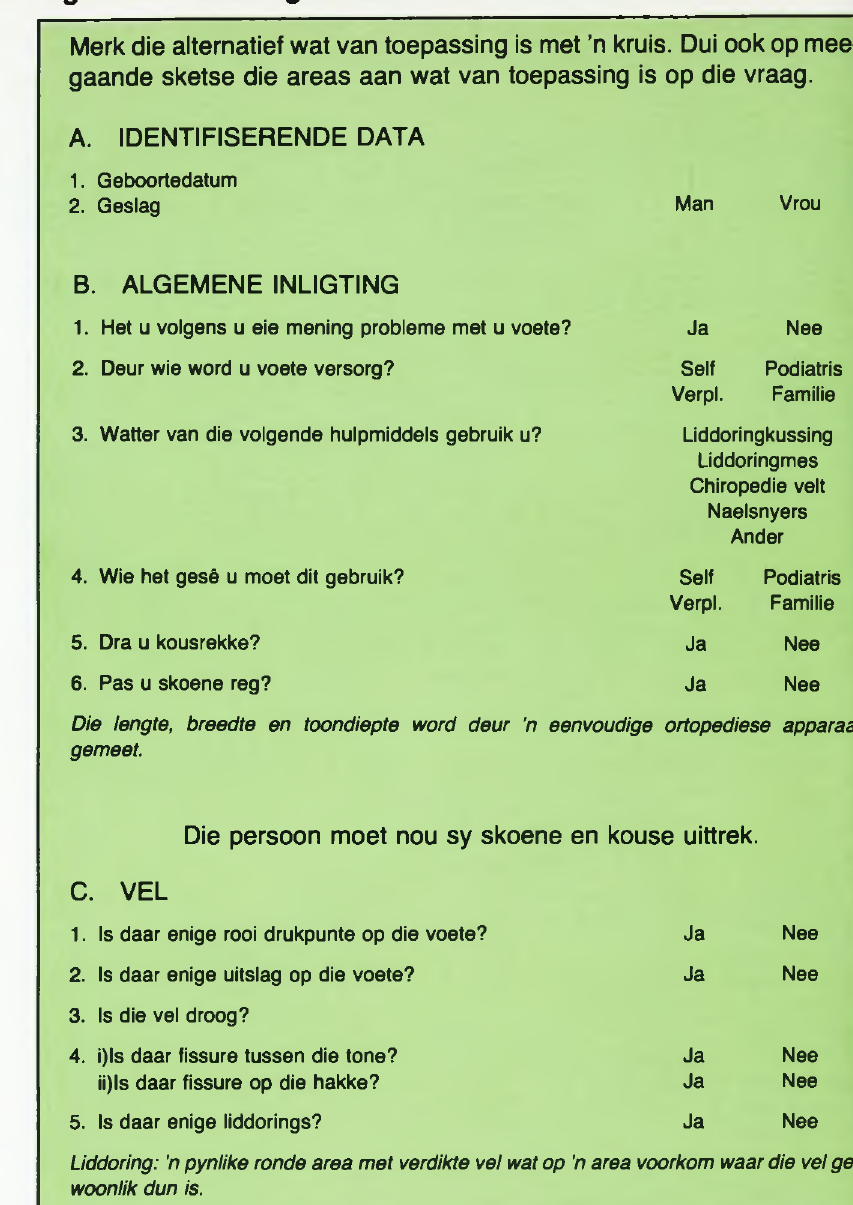
Figuur 1 Evalueringskedule Merk die alternatief wat van toepassing is met ’n kruis. Dui ook op